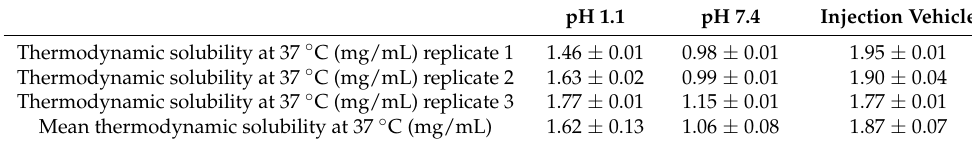
Figure 4. Compound 2 stability for 72 h at 37 °C in pH 1.1, in pH 7.4 and in an injection vehicle composed of 0.9% NaCl and 0.1% Polysorbate 80 pH 7.4. Table 1. Thermodynamic solubility of compound 2 in those three different media after 72 h at 37 °C.